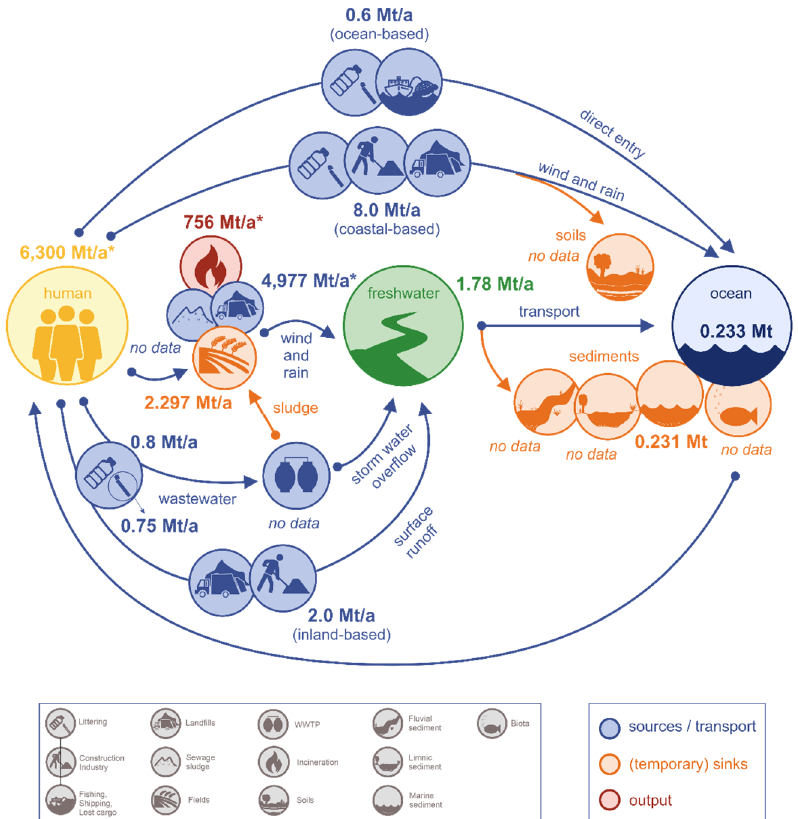
Figure 3. Sources and transport paths of macroplastic with approximate accounting of mass budget if data are available, * data from 2015 (based on [16], data and calculations from [4,42,44,51–57]).